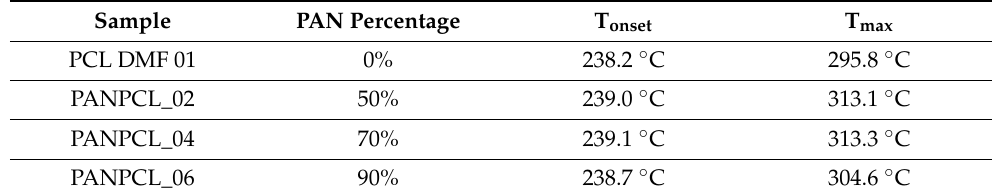
Figure 5. TGA of PAN/PCL samples of different composition performed under nitrogen atmosphere at the heating rate of 10 °C per min. Table 9. T onset and T max values of DTA curves related to the polymer composition.